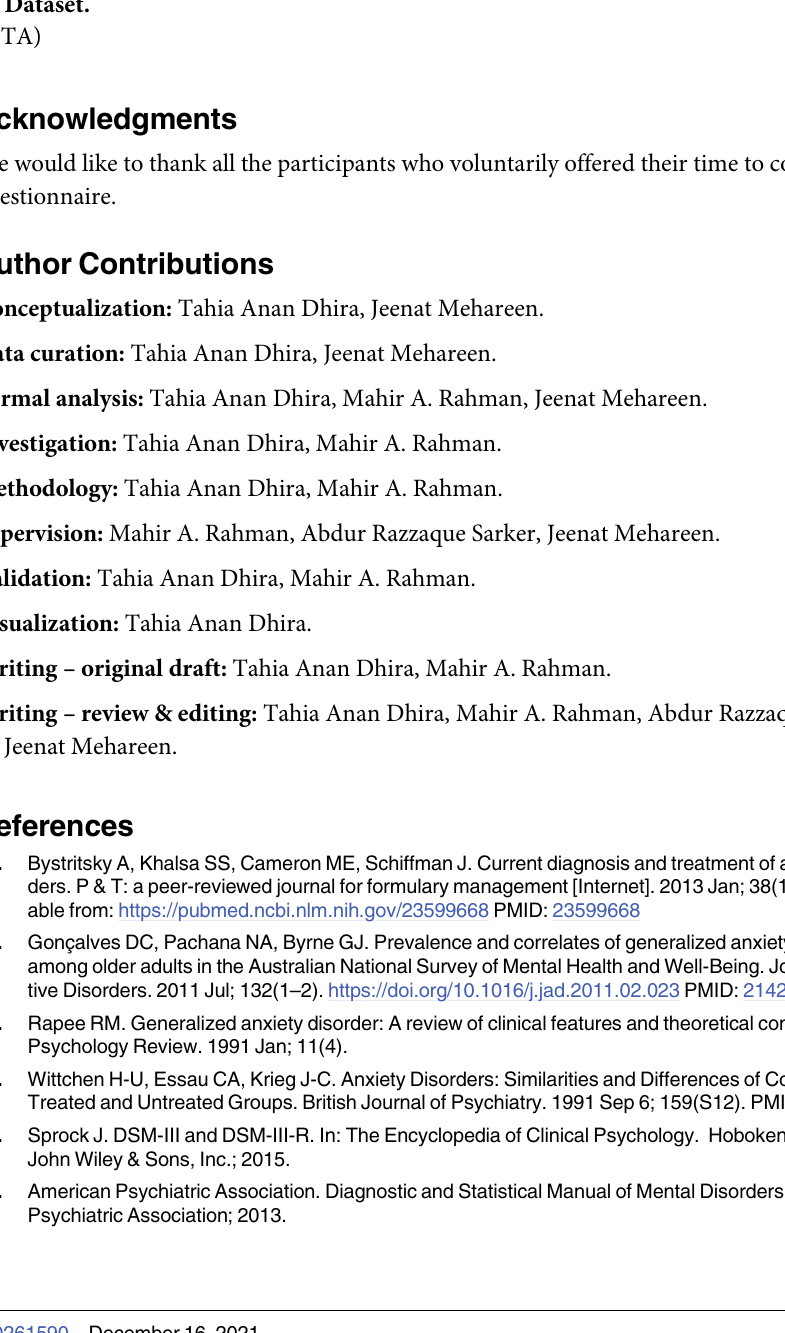
S1 Table. Pearson’s correlation coefficients (r) between GAD-7 items and with other ques- tionnaires, ( n = 677). S2 Table. Eigenvalue, percentage of variance, and cumulative percentage of variance for the factors derived from EFA for PHQ-9 items. S3 Table. Distribution of GAD-7